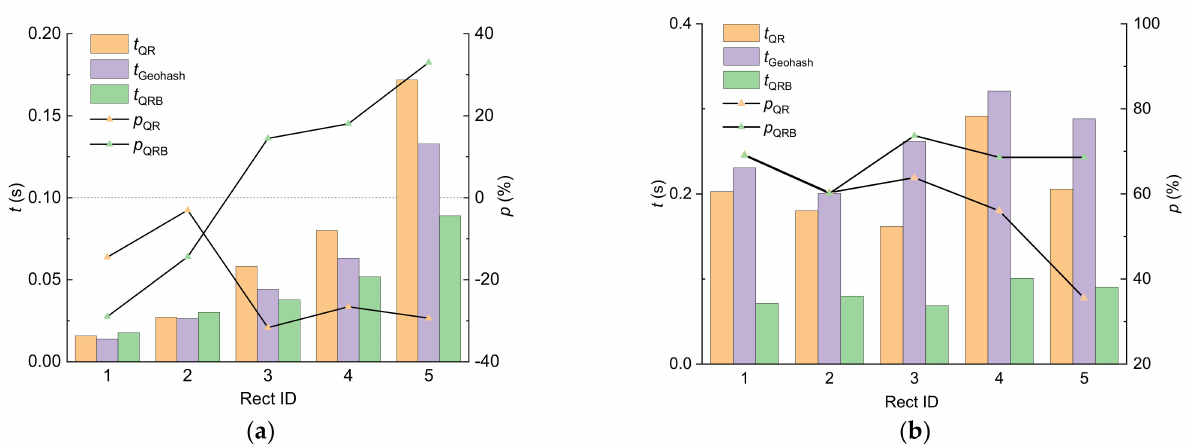
Figure 14. Comparisons among QRB-tree ( QRB ), QR-tree ( QR ), and geohash. The right axis indicates the percentage of improvement ( p ) over geohash, i.e., ( t Geohash − t X ) / t Geohash , where X refers to QR or QRB . ( a ) Comparison of rough queries. ( b ) Comparison of exact queries. The refinement methods used in the exact queries for the three cases are the proposed, traditional, and traditional.